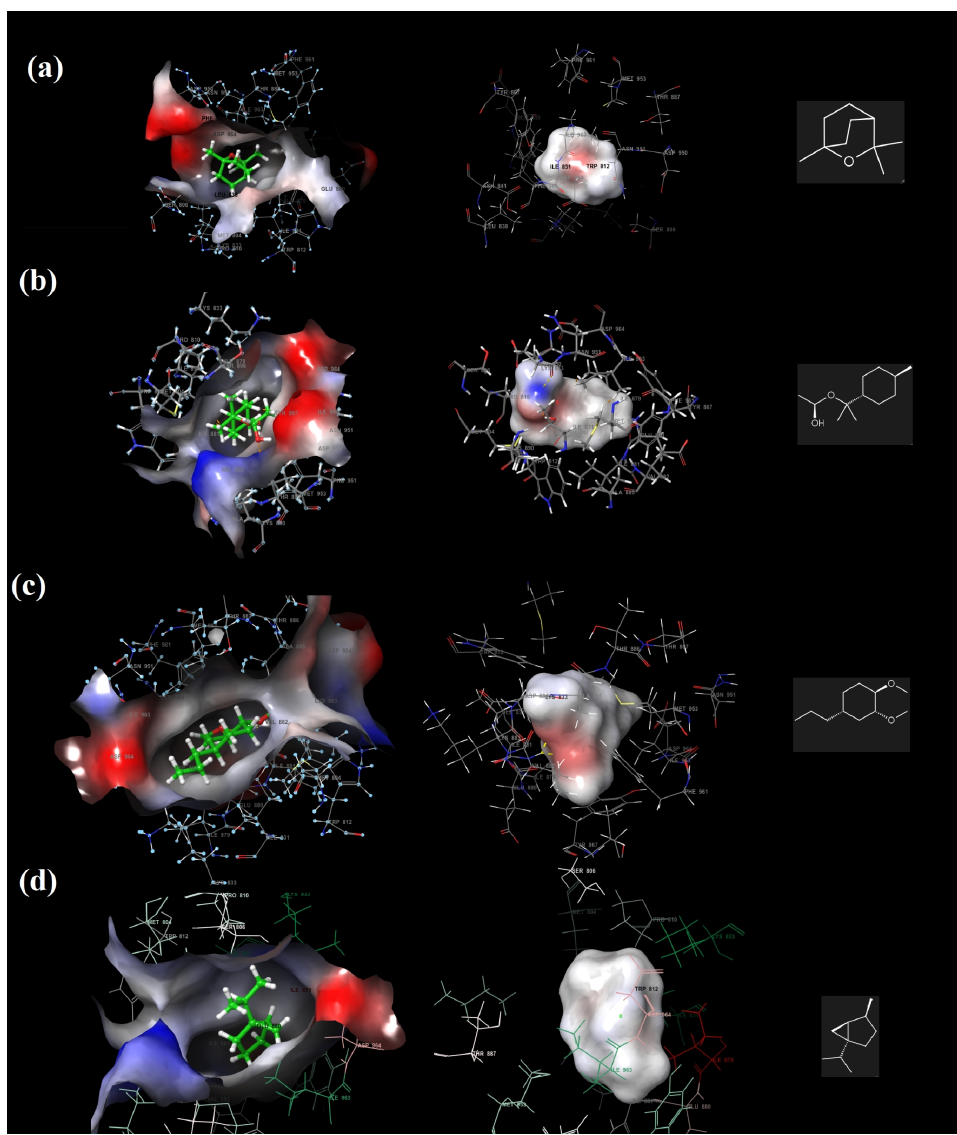
Figure 3. The band edge positions of the MoTe 2 /PtS 2 vdWH with different stacking structures Figure 11. The electrostatic potentials of the binding pocket of the PI3K/mTOR target receptor and against the redox potential energy of the water-splitting at pH 0. 1,8-cineole ( a ), α -terpinyl acetate ( b ), methyleugenol ( c ) and sabinene ( d